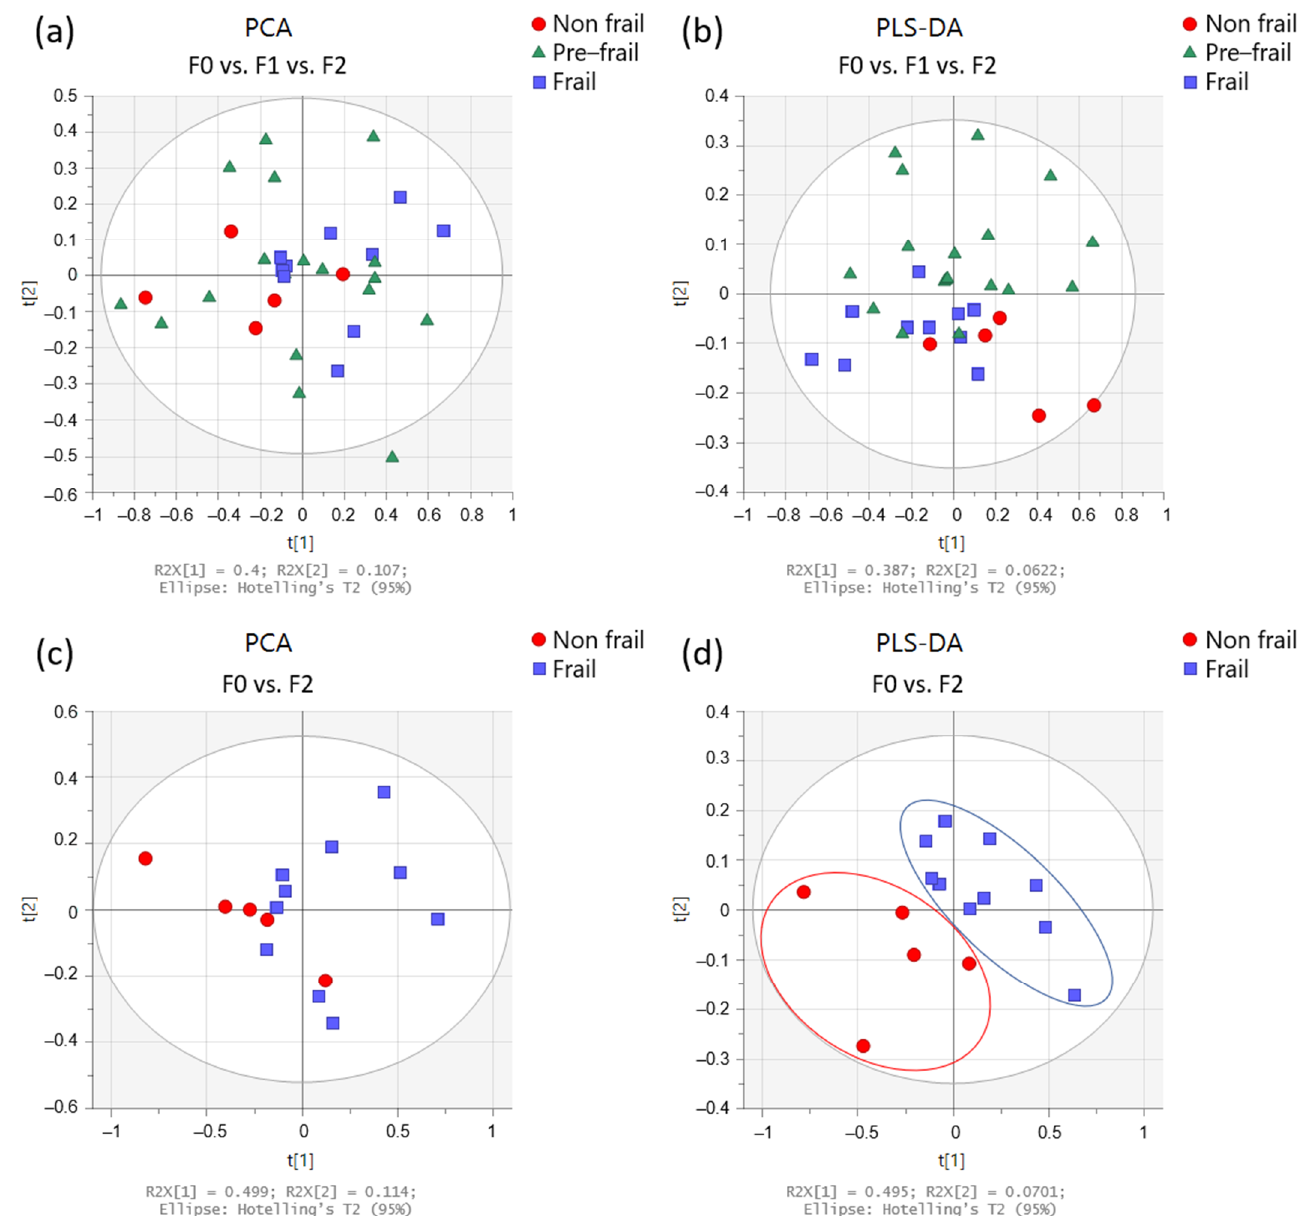
Figure 2. Multivariate analysis obtained from urine spectra of the participants (n = 33). Score plots from PCA (left panels) and PLS-DA (right panels) according to frailty severity: ( a , b ) in non-frail (red circles; n = 5), pre-frail (green triangles; n = 18), and frail (blue squares; n = 10) participants, and ( c , d ) in non-frail (red circles) and frail (blue squares) participants.